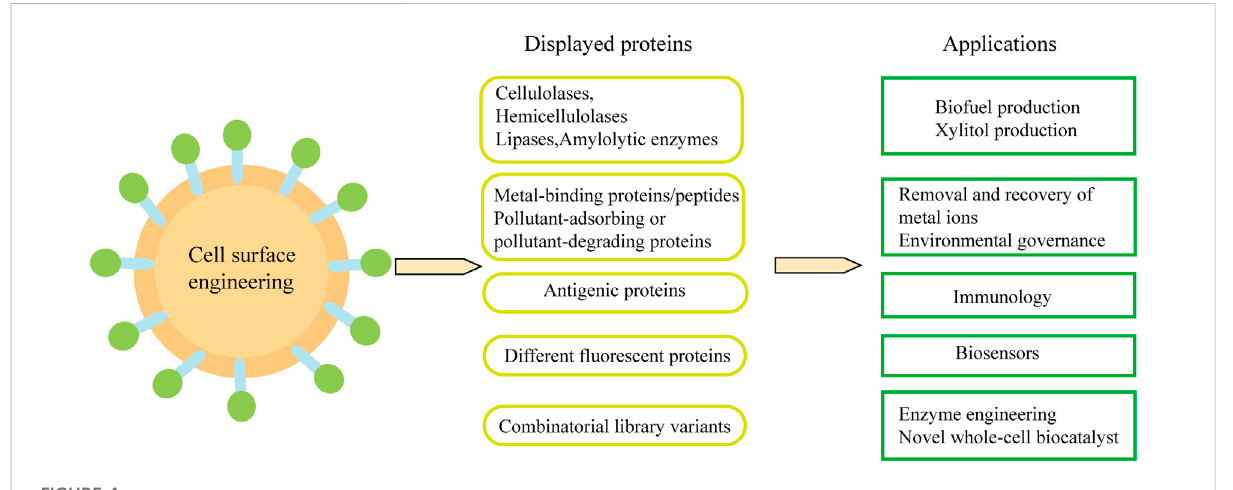
FIGURE 4 Applications of S. cereviaiae cell surface